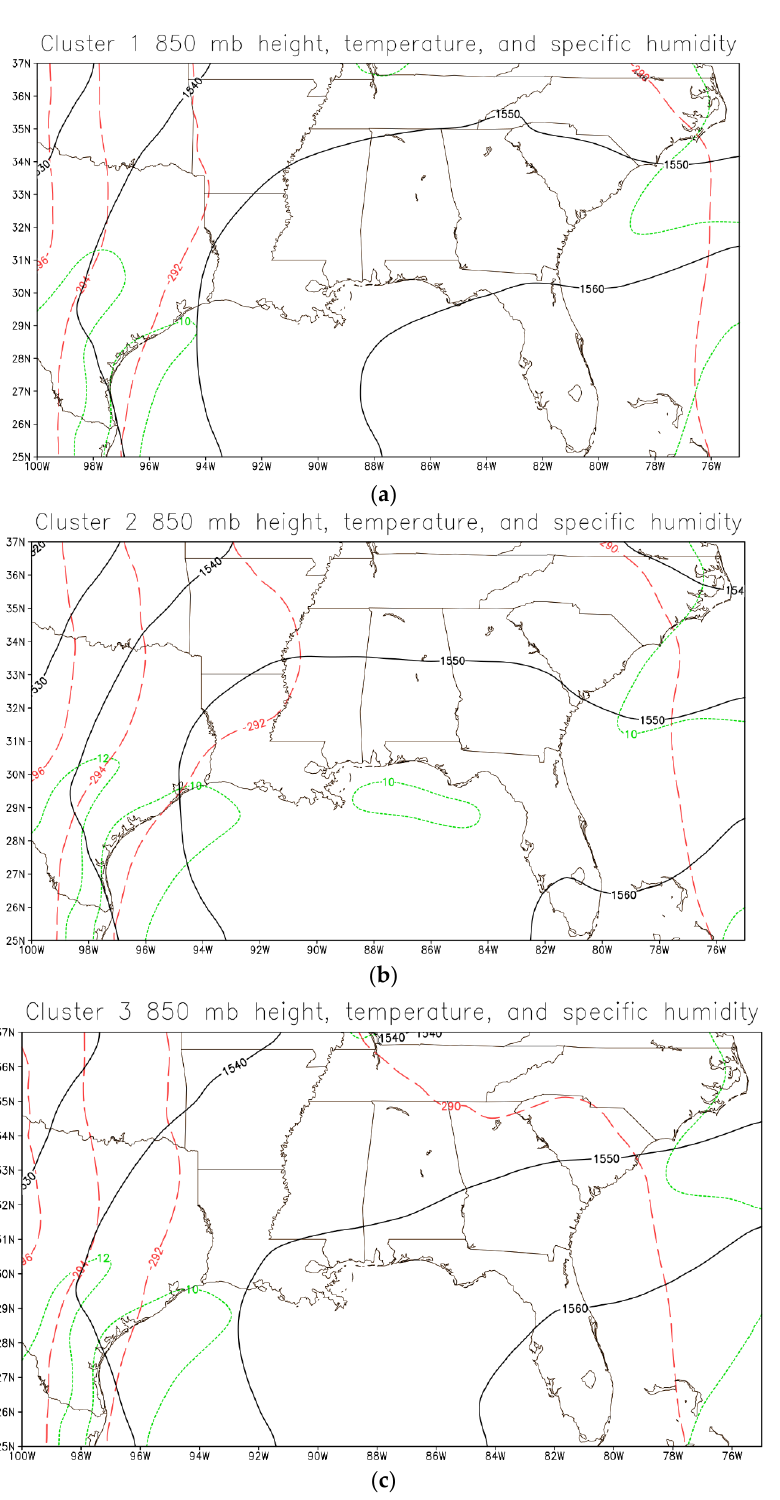
Figure 9. Composite averages for clusters 1 – 3 (panels a – c ) of geopotential height (black contours — m), temperature (red dashed contours — K) and specific humidity (green dotted contours — g/kg) for 850 mb.